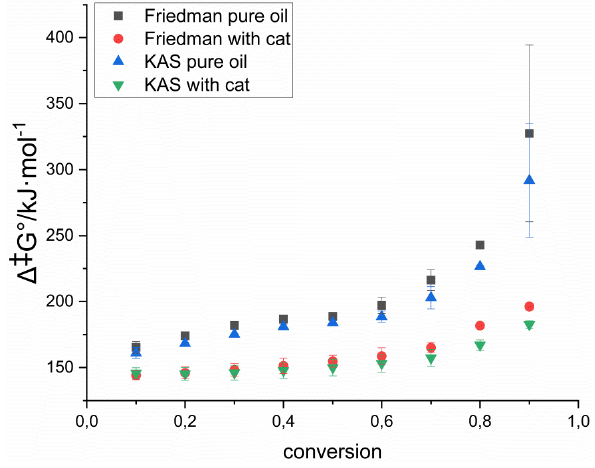
Figure 9. Dependency of the activation Gibbs energy vs. conversion for catalytic and non-catalytic peat pyrolysis.